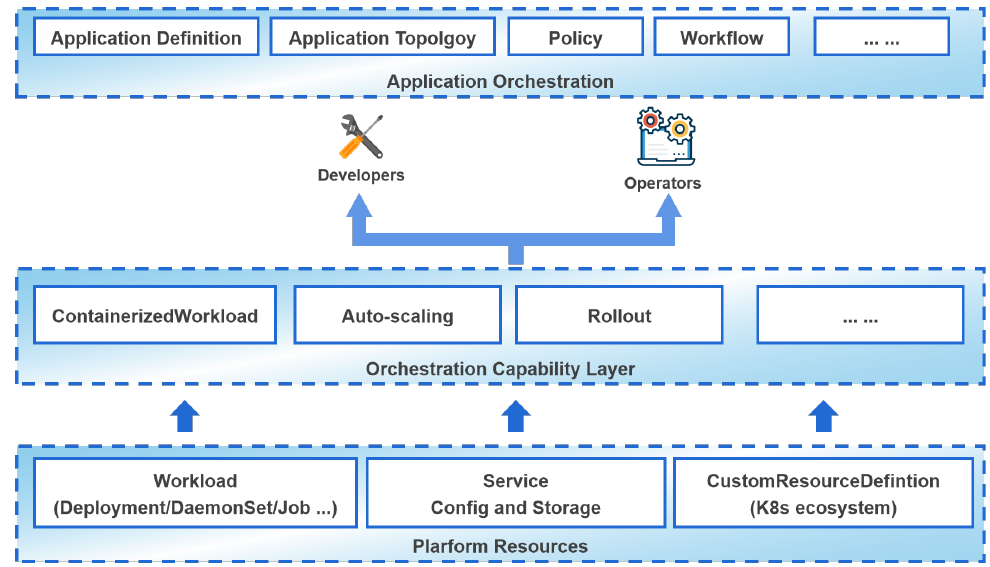
Figure 5. Role-based cloud application